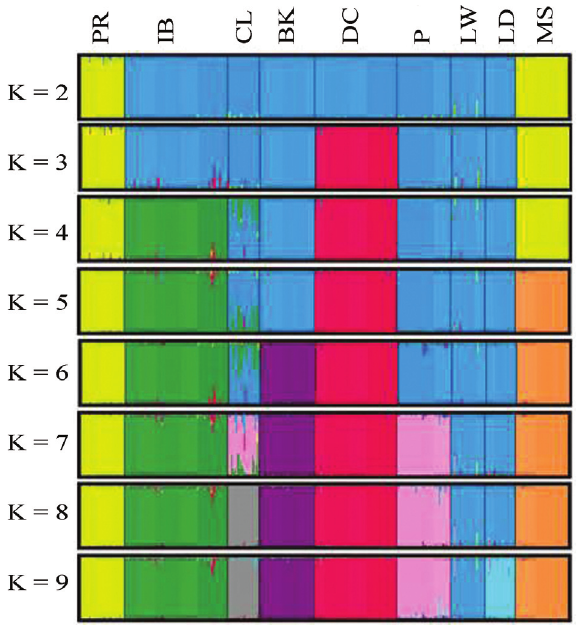
Figure 2 - Neighbour-joining tree based on Nei’s genetic distances (D A ). Breed abbreviations: BK – Berkshire, CL – Celtic, DC – Duroc, IB – Ibe- rian,LD–Landrace,LW–LargeWhite,MS–Meishan,P–Pietrain,PR– Pampa Rocha.